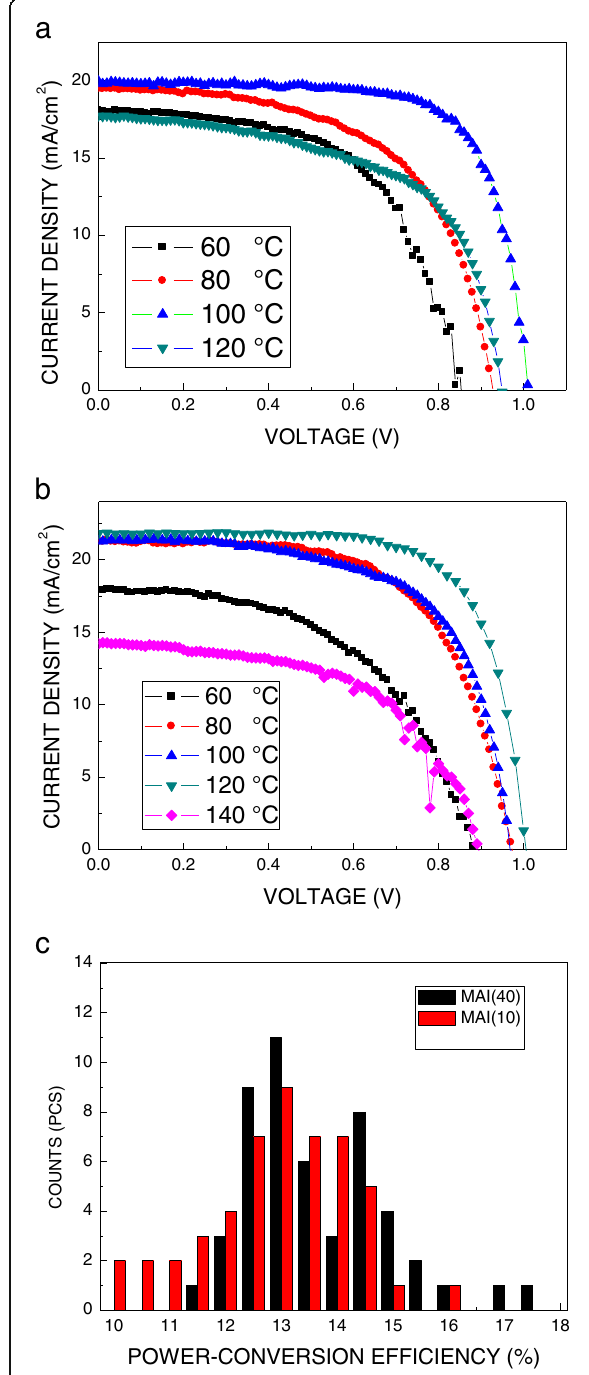
Fig. 8 J-V curves of the perovskite solar cells prepared using a low-concentration MAI and b high-concentration MAI with different annealing temperatures. c Histograms of PCE of the perovskite solar cells prepared by high-concentration MAI under the optimum process condition for 50